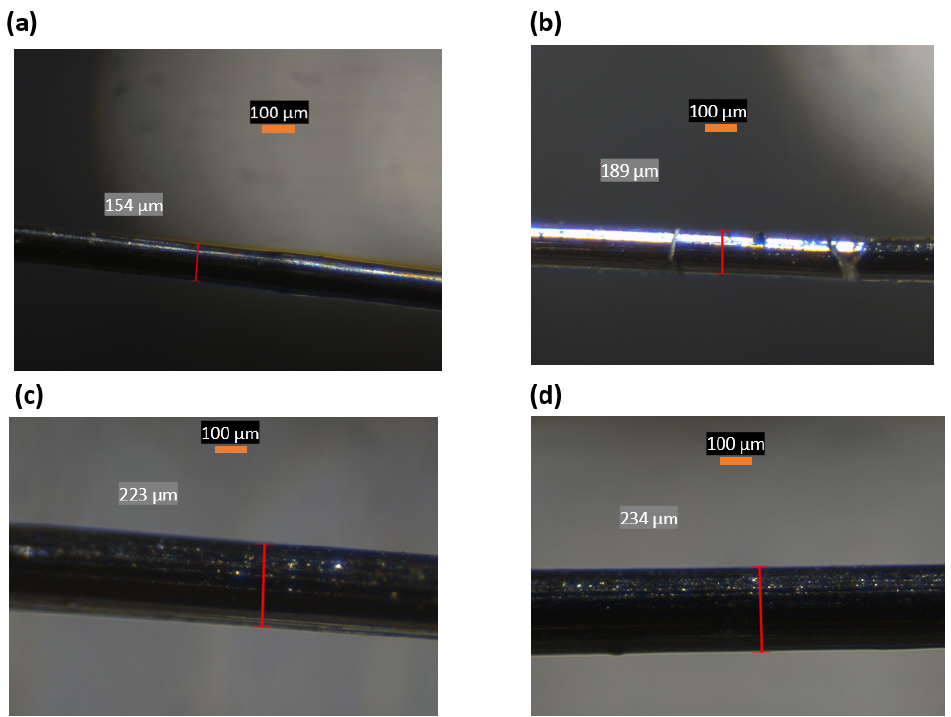
Figure 3. Images of LLDPE/MP fibres extrusion dwell times: ( a ) 0, ( b ) 6, ( c ) 8, and ( d ) 10 min.